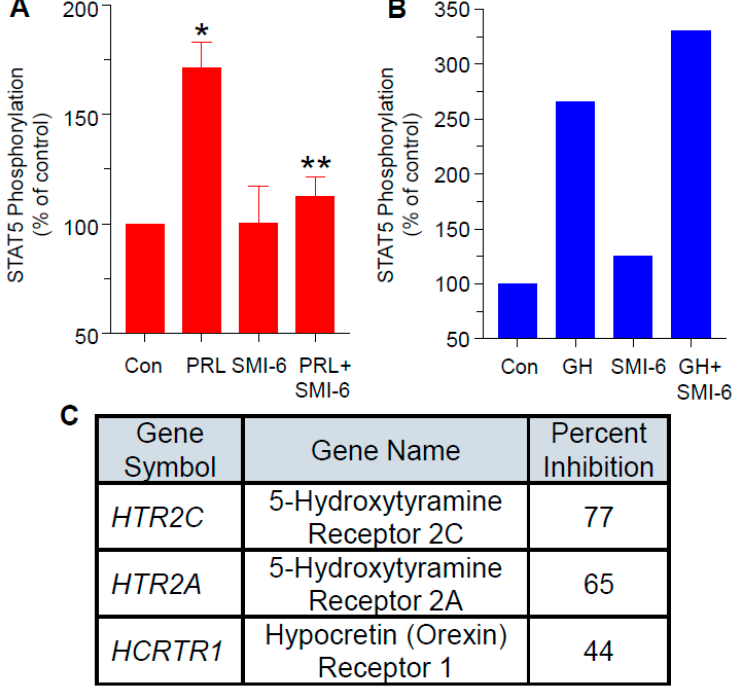
Figure 4. Effects of SMI-6 on induction of STAT phosphorylation by PRL or GH. MDA-MB-468 cells ( A ) or PRLR-deficient T47D cells that express the GHR ( B ) were used. Values for ( A ) are means ± SEM ( n = 3). * significant ( p < 0.05) vs. control, ** significant ( p < 0.05) vs. PRL. Values for ( B ) are means ( n = 2). PRL or GH were used at 10 nM; SMI-6 was used at 10 μ M. ( C ) Results of selectivity screening of SMI-6 by DiscoverX against 168 G-protein-coupled receptors. SMI-6 caused inhibition of only 3 receptors: serotonin receptor 2C (HTR2C), serotonin receptor 2A (HTR2A), and hypocretin receptor 1 (HCRTR1). When tested against 468 kinases, SMI-6 had no activity against any kinase, including JAK2.